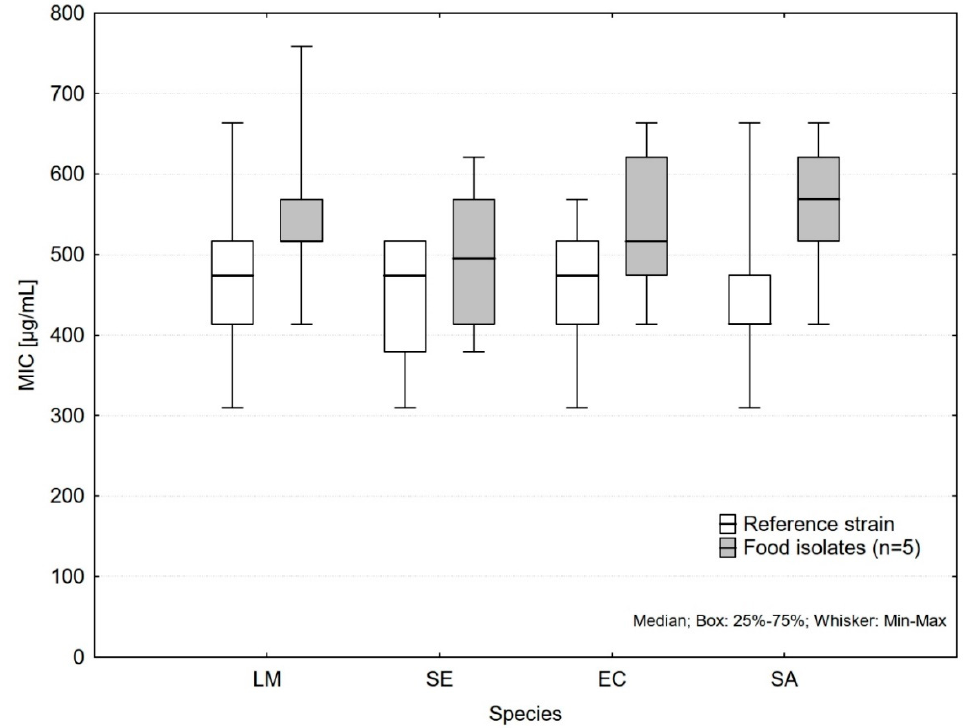
Figure 1. Differences in MIC between reference strains and mixtures of food isolates (LM, Listeria monocytogenes ; SE, Salmonella Enteritidis; EC, Escherichia coli O157; SA, Staphylococcus aureus ).